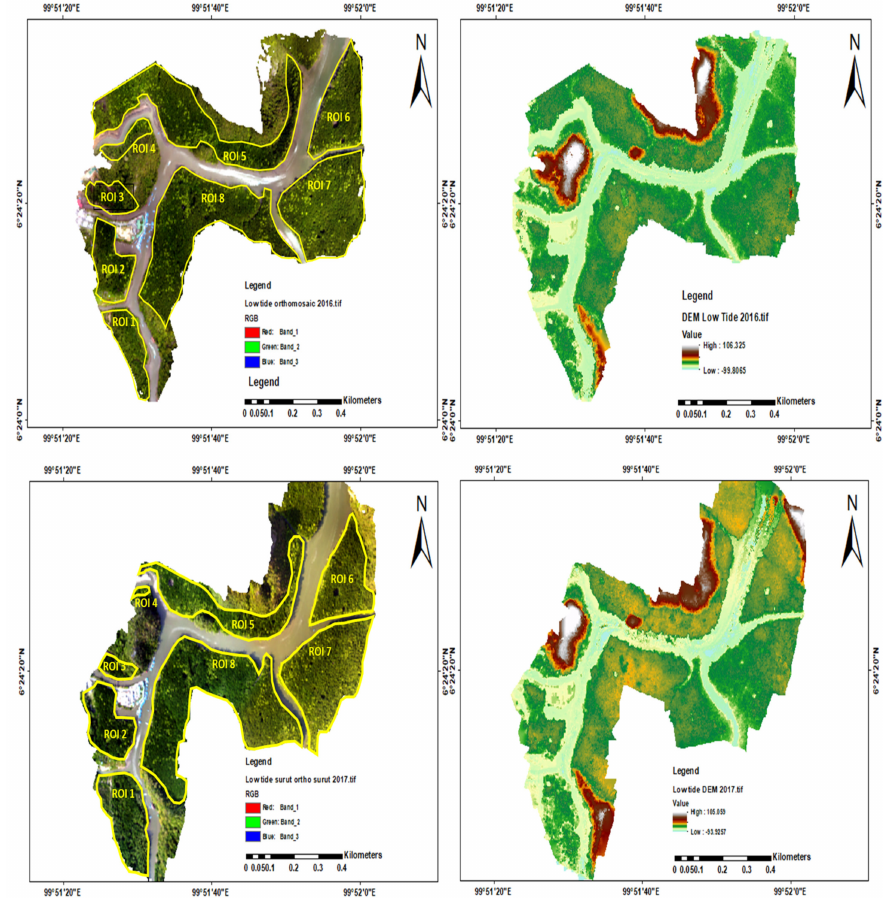
Figure 5. ( Top image: Orthophoto and DSM results at low tide in 2016; Bottom image: Orthophoto and DSM results at low tide in 2017); (Red highlights ROI: Eight different regions as the primary focus of this